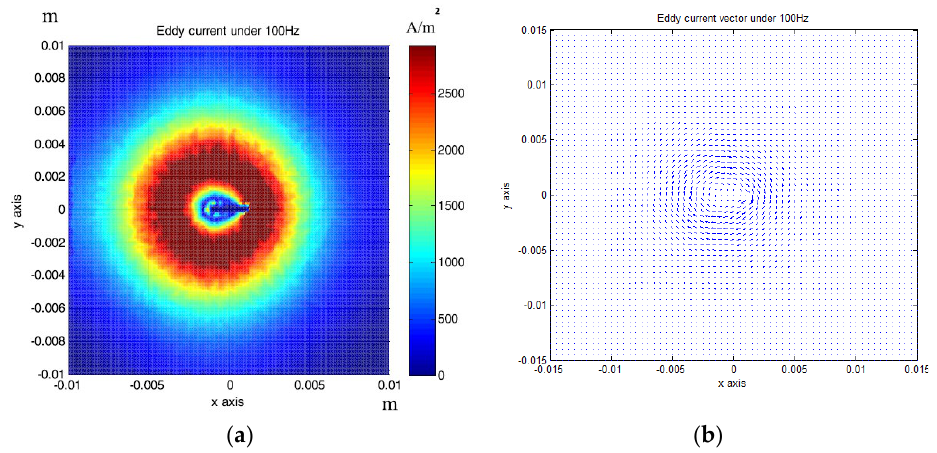
Figure 4. Eddy current performance using an accelerated FEM solver: ( a ) Color map; ( b ) quiver map [42].